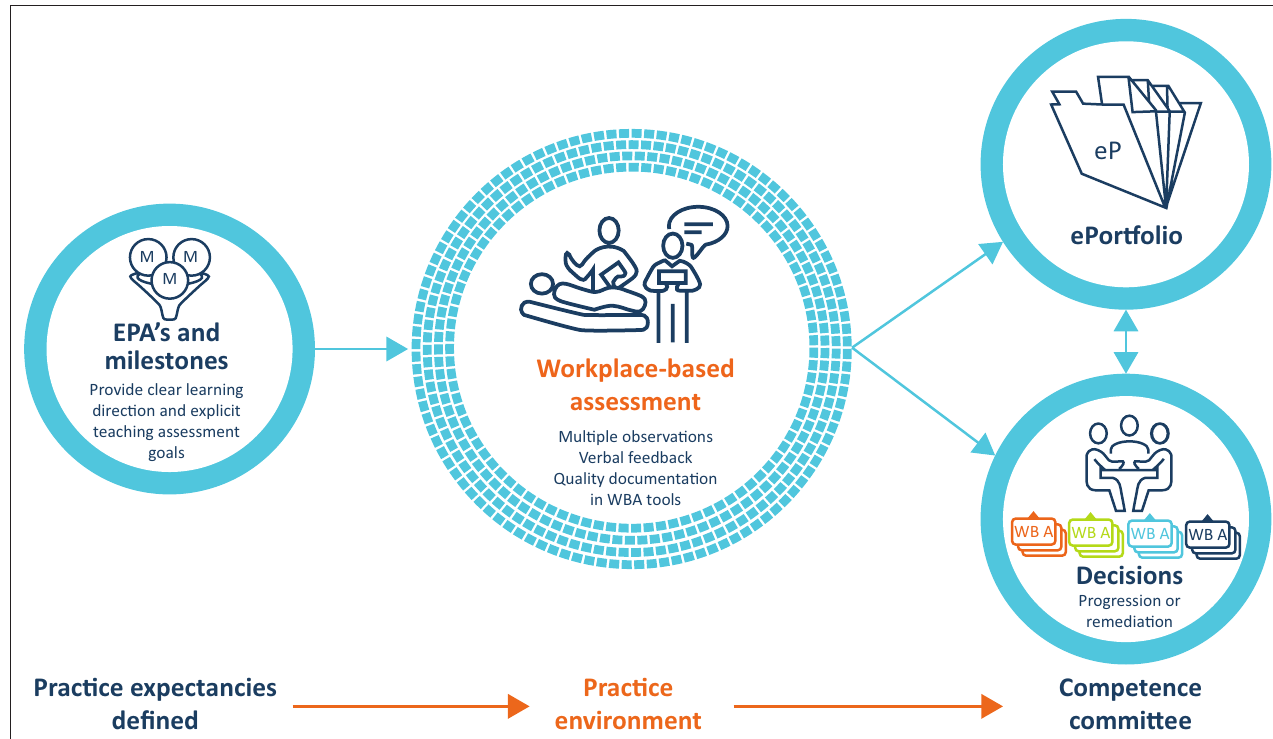
Prac(cid:27)ce environment